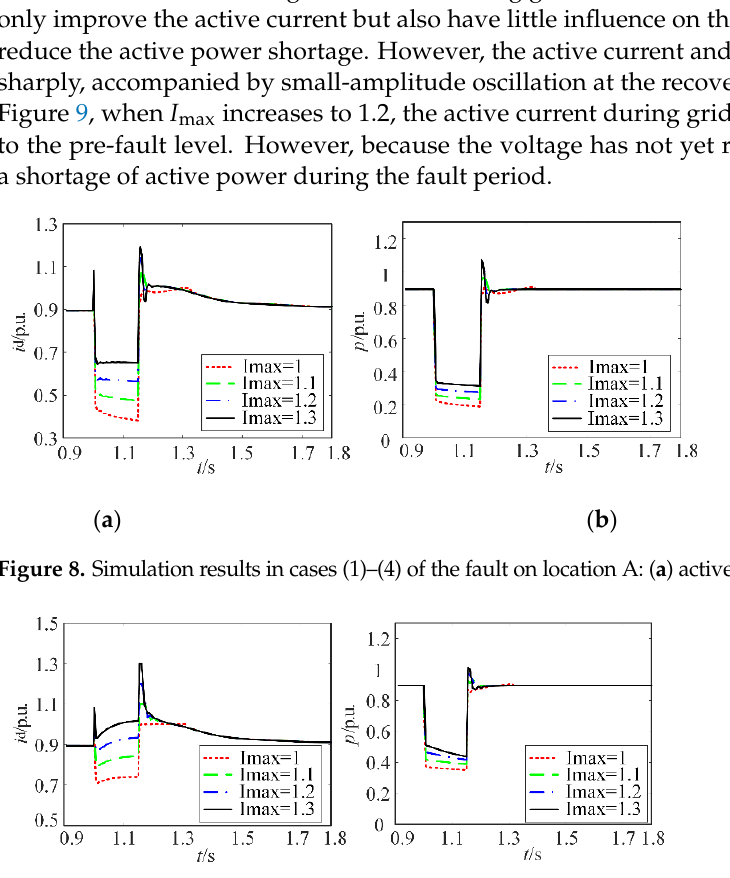
Figure 7. Simulation results in case (1) of the fault on location A: ( a ) active output of PV generator; ( b ) reactive output of PV generator.